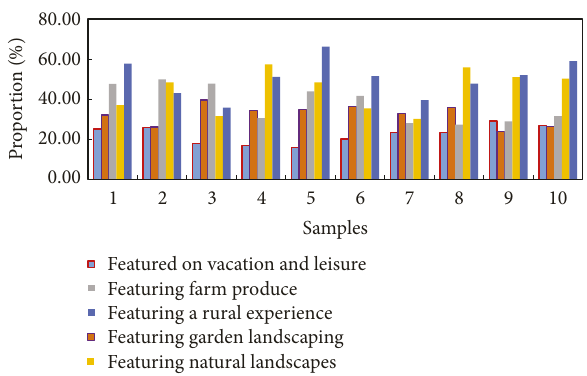
Figure 9: Positioning and development of ecological agriculture park in M